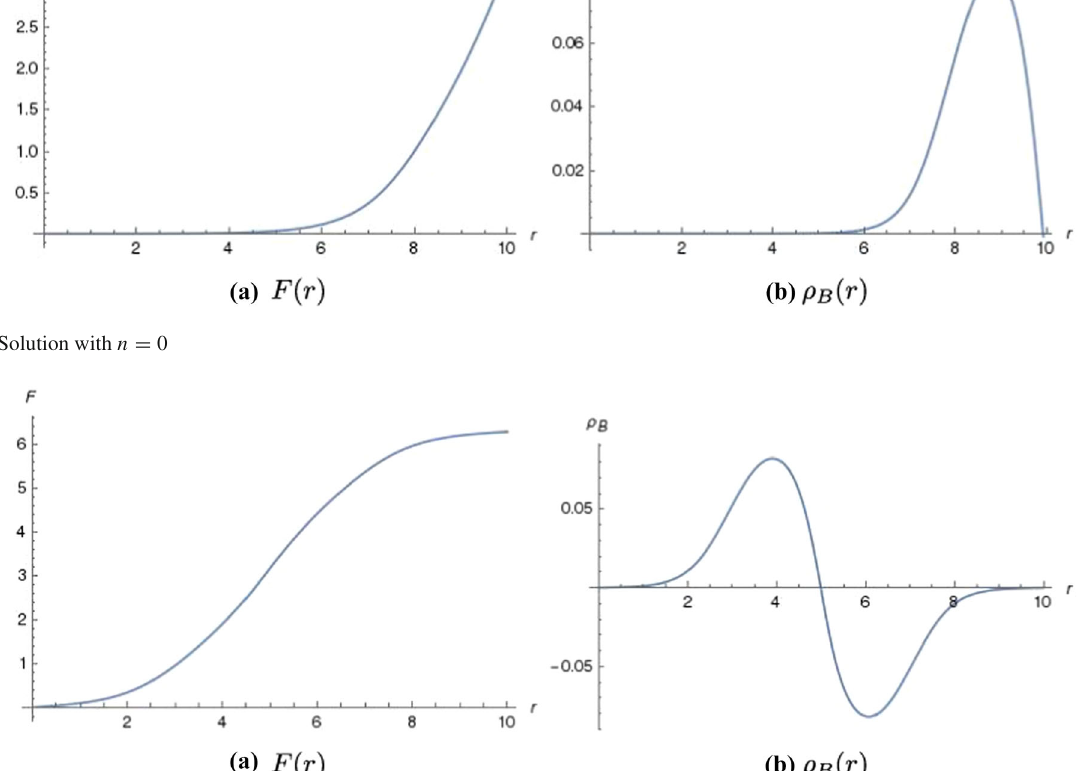
Fig. 2 Solution with m =